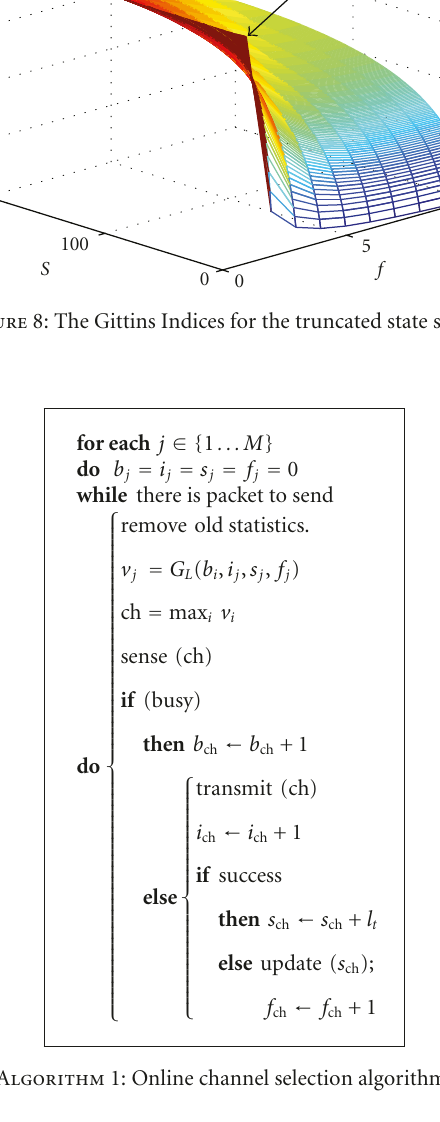
Algorithm 1: Online channel selection